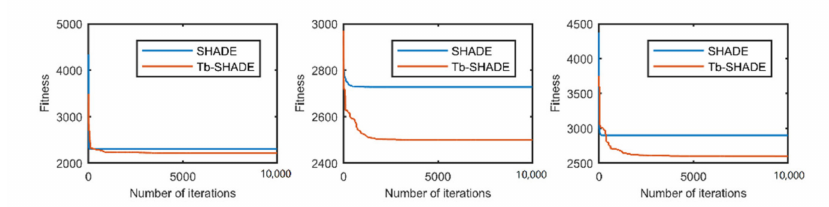
Figure 2. The selected average convergence of SHADE and Tb-SHADE is compared on CEC2020 in 10 D . From left to right f8, f9 and